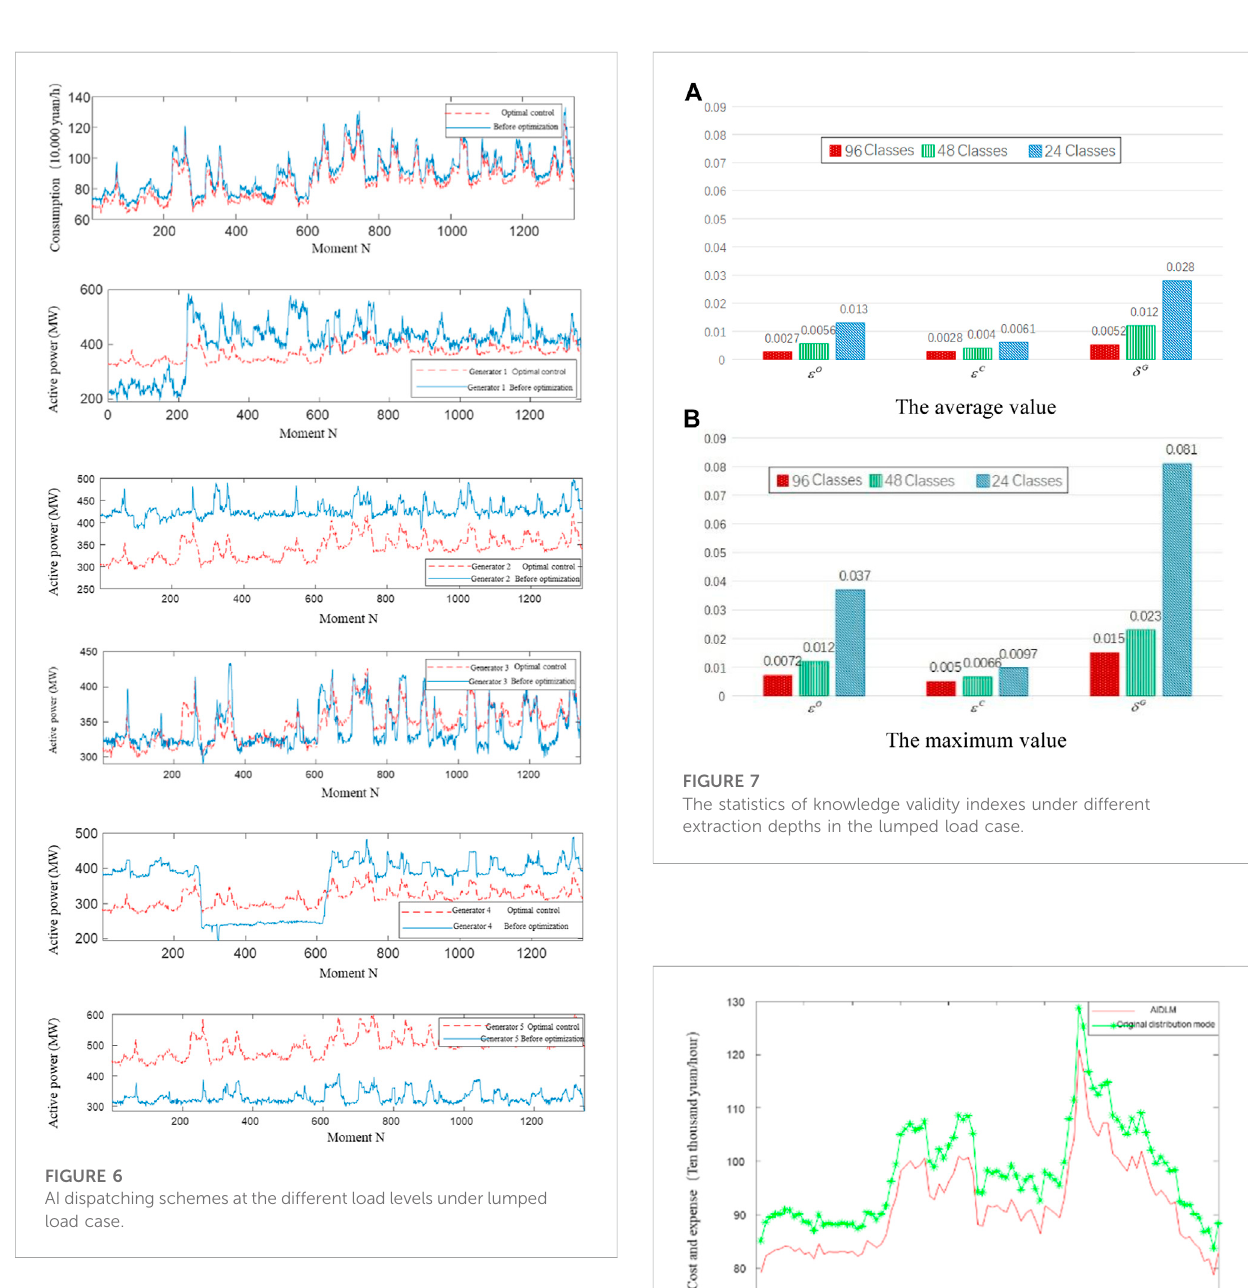
FIGURE 8 The generating cost curves of the AI dispatching and the real system in the lumped load